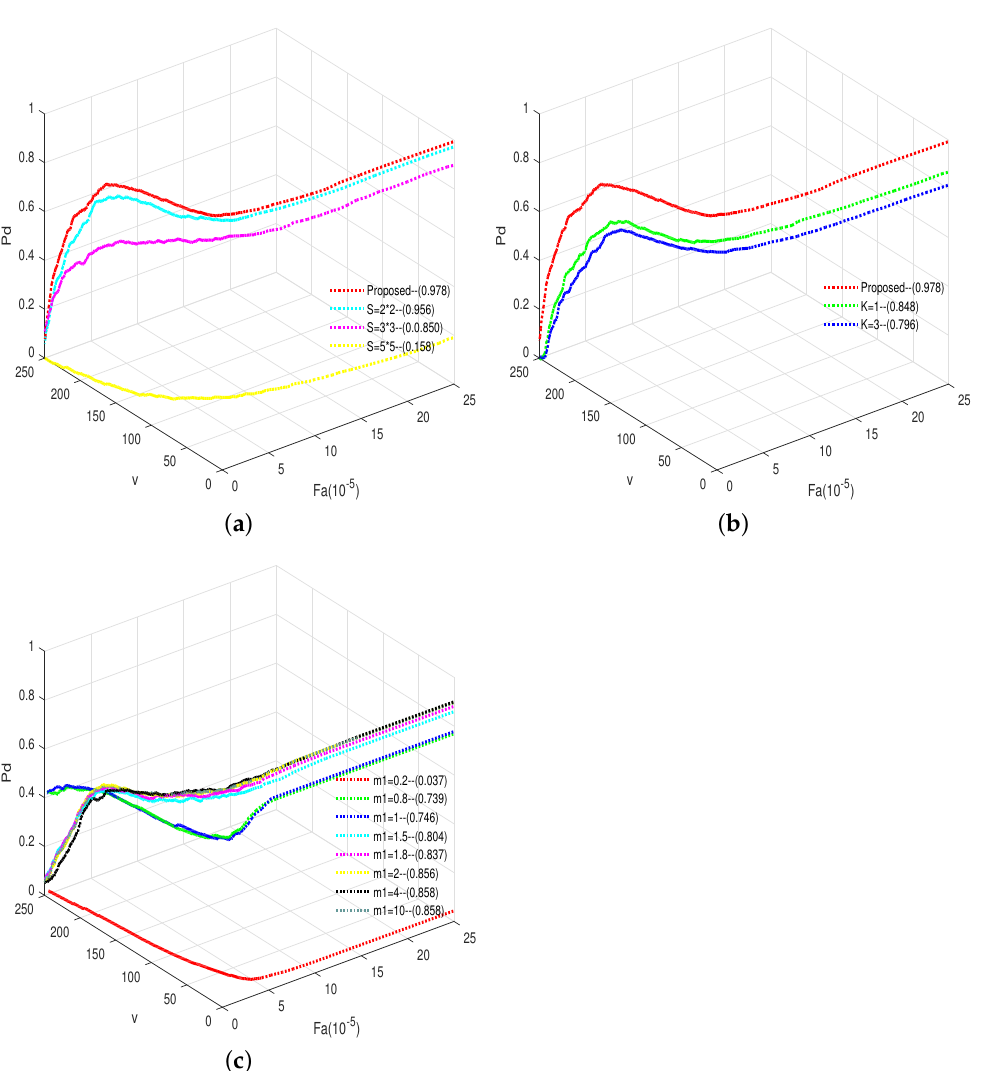
Figure 13. 3-D curves of parametric analysis, showing detection probability versus the false alarm rate and the parameter vs. in Equation (22). In the legends, the corresponding AUCS are shown. ( a ) S represents the scale size of the window, ( b ) K represents the scale size of the sub-window, and ( c ) the sizes of m 1 and m 2 represent different weights and m 2 is fixed at